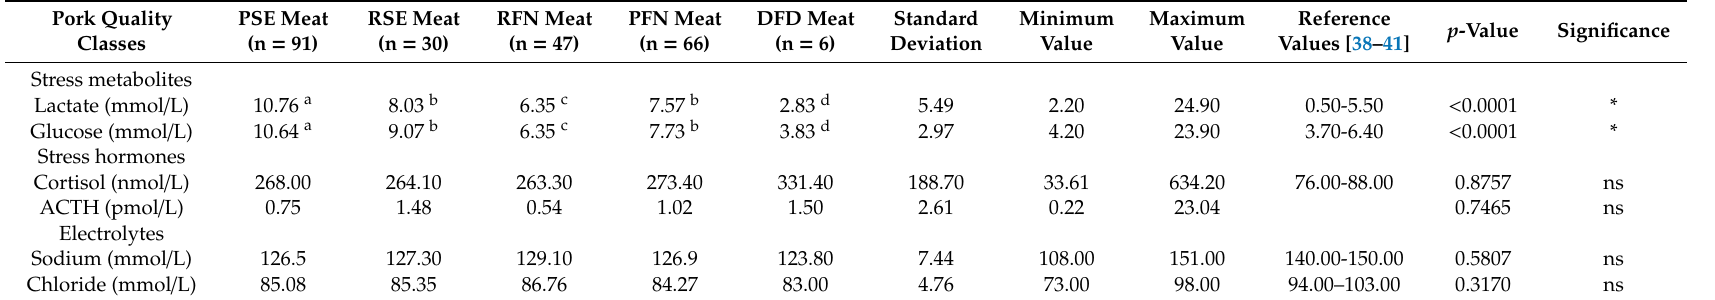
Table 4. Di ff erences in stress metabolites, stress hormones, and electrolytes between pork quality